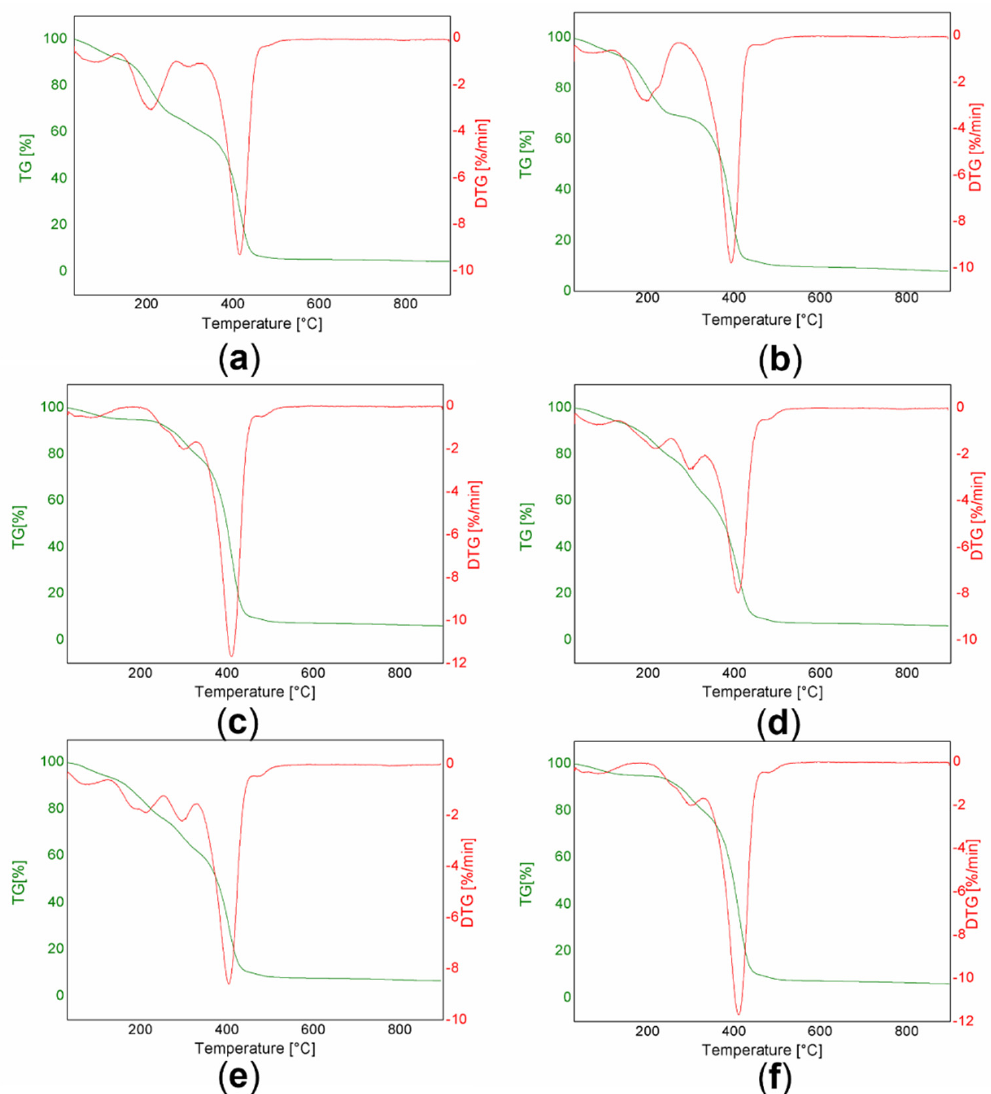
Figure 6. TG and DTG curves of hydrogels; sample ( a ) S1G1; ( b ) S2G1; ( c ) S3G1; ( d ) S4G1); ( e ) S2G0.5 and ( f ) S2G0.